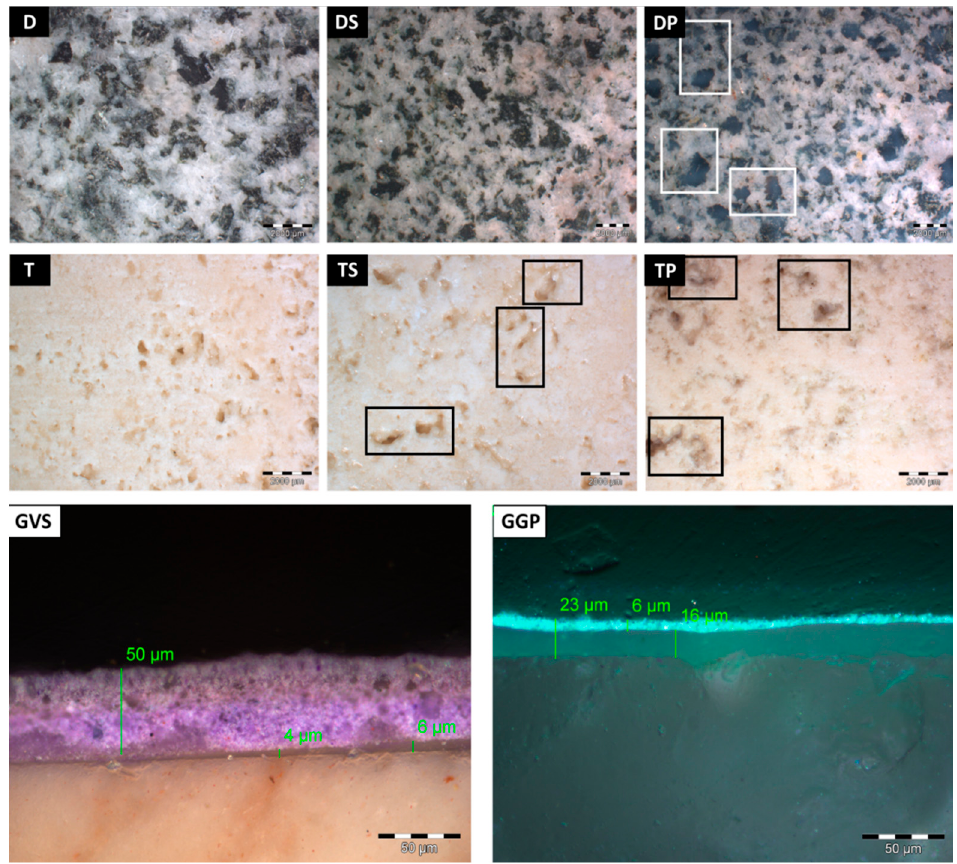
Figure 3. Micrographs captured by the stereomicroscopy of stones tested with both anti-graffiti sacrificial and permanent products. Moreover, micrographs of cross sections are provided (GVS and GGP), in order to show the thickness of the anti-graffiti coatings and paint layers. Check Table 1 for sample labeling.